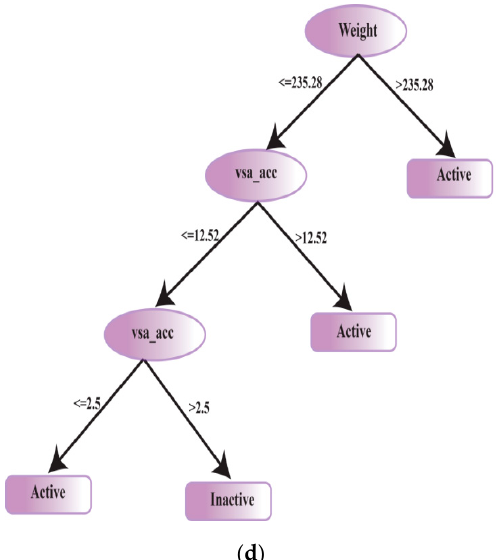
Figure 9. ( a ) A J-48-pruned decision tree for CYP1A2 inhibitors based on HBD_HBA, sCenters, HBA and molecular weight. ( b ) A J-48-pruned decision tree for CYP2C9 inhibitors based on molecular weight, HBD and logD. ( c ) A J-48-pruned decision tree for CYP2D6 inhibitors based on total charge, stereocenters, HBD, HBA, logP, rings and molecular weight descriptors. ( d ) A J-48-pruned decision tree for CYP3A4 inhibitors based molecular weight and vsa_acc from the set of selected descriptors.